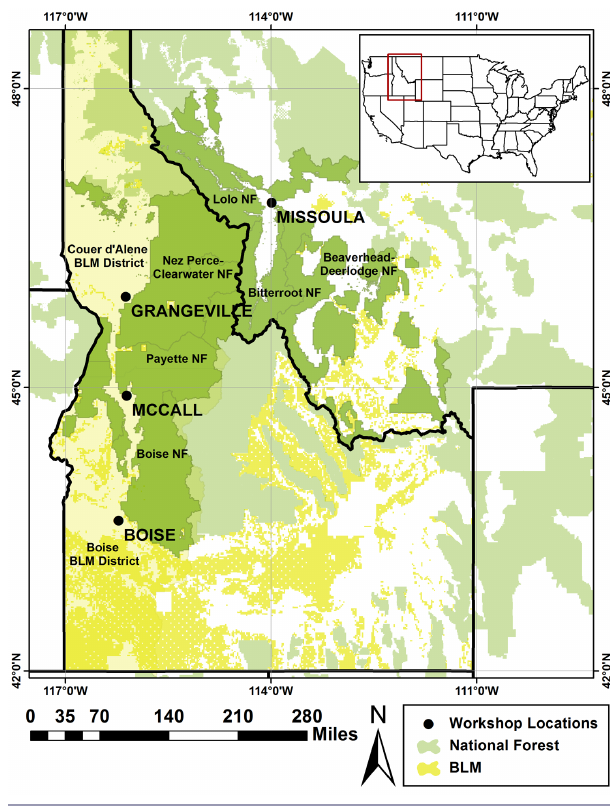
Fig. 1 . Map of the study area highlighting the National Forests (dark green) and Bureau of Land Management (BLM) districts (light yellow) represented by workshop participants. Participants were from six national forests and two BLM districts. The majority of land area in the U.S. northern Rocky Mountains (defined here as Idaho and western Montana) is federal land under the control of the US Forest Service (light green) and BLM (bright